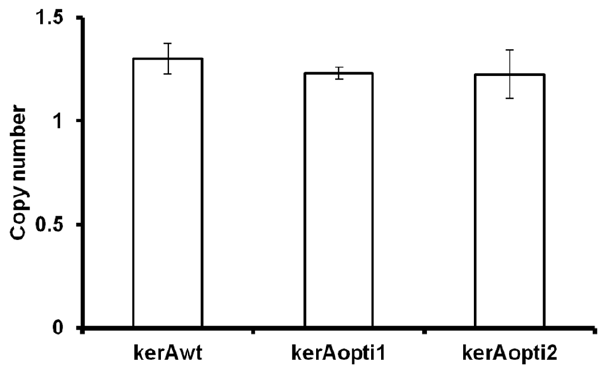
Figure 1. Comparative the target gene copy numbers of P. pastori pPICZ a -kerAwt, pPICZ a -kerAopti1 and pPICZ a -ker- Aopti2. The values represent means 6 SD (n=3). Results showed no significant difference in gene copy numbers of every positive transformant (P . 0.05).